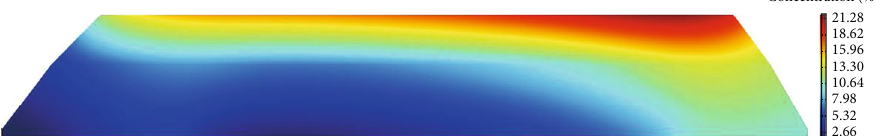
Figure 9: Plane diagram of gas concentration distribution at a depth of 45m in goaf.